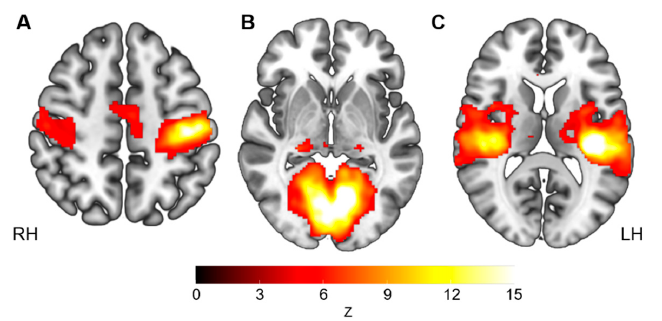
Figure 1. Group maps of the sensorimotor ( A ), visual ( B ) and auditory ( C ) networks for the youth with cerebral palsy, based on resting-state functional connectivity. Functional connectivity maps were constructed using a seed located in the ( A ) left precentral cortex (x = − 41, y = − 20, z = 62), ( B ) left lingual gyrus (x = − 16, y = − 74, z = − 7) or ( C ) left Heschl gyrus (x = − 40, y = − 24, z = 9). Results are presented in radiological view. Table 2. Whole-brain functional connectivity differences between the neurotypical controls and youth with cerebral palsy. Regions Hemisphere